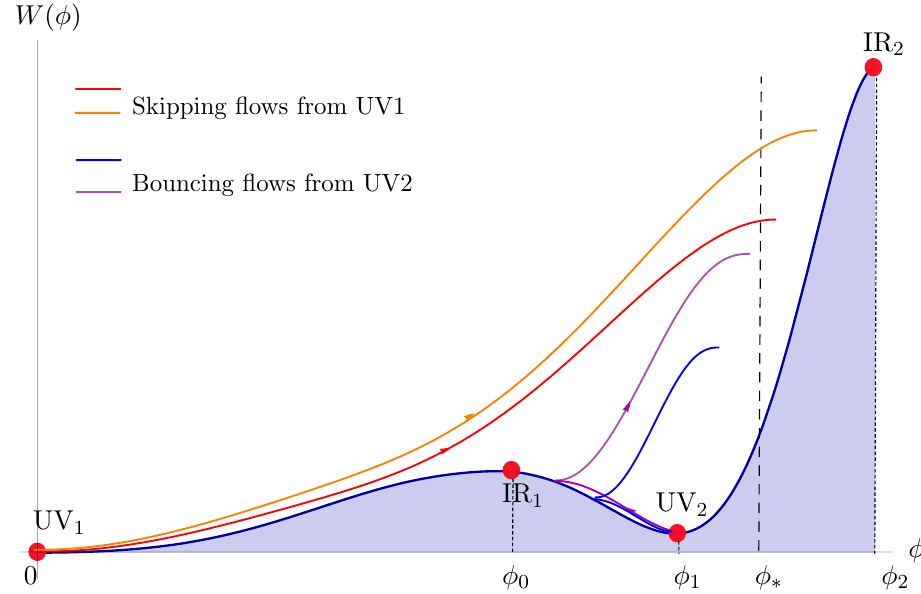
Figure 16 . The approach to (cid:30) h = (cid:30) (cid:3) from both sides. The curves show the superpotentials of the corresponding (cid:13)ows. Here we display (cid:13)ows with di(cid:11)erent temperatures (longer (cid:13)ows correspond to lower